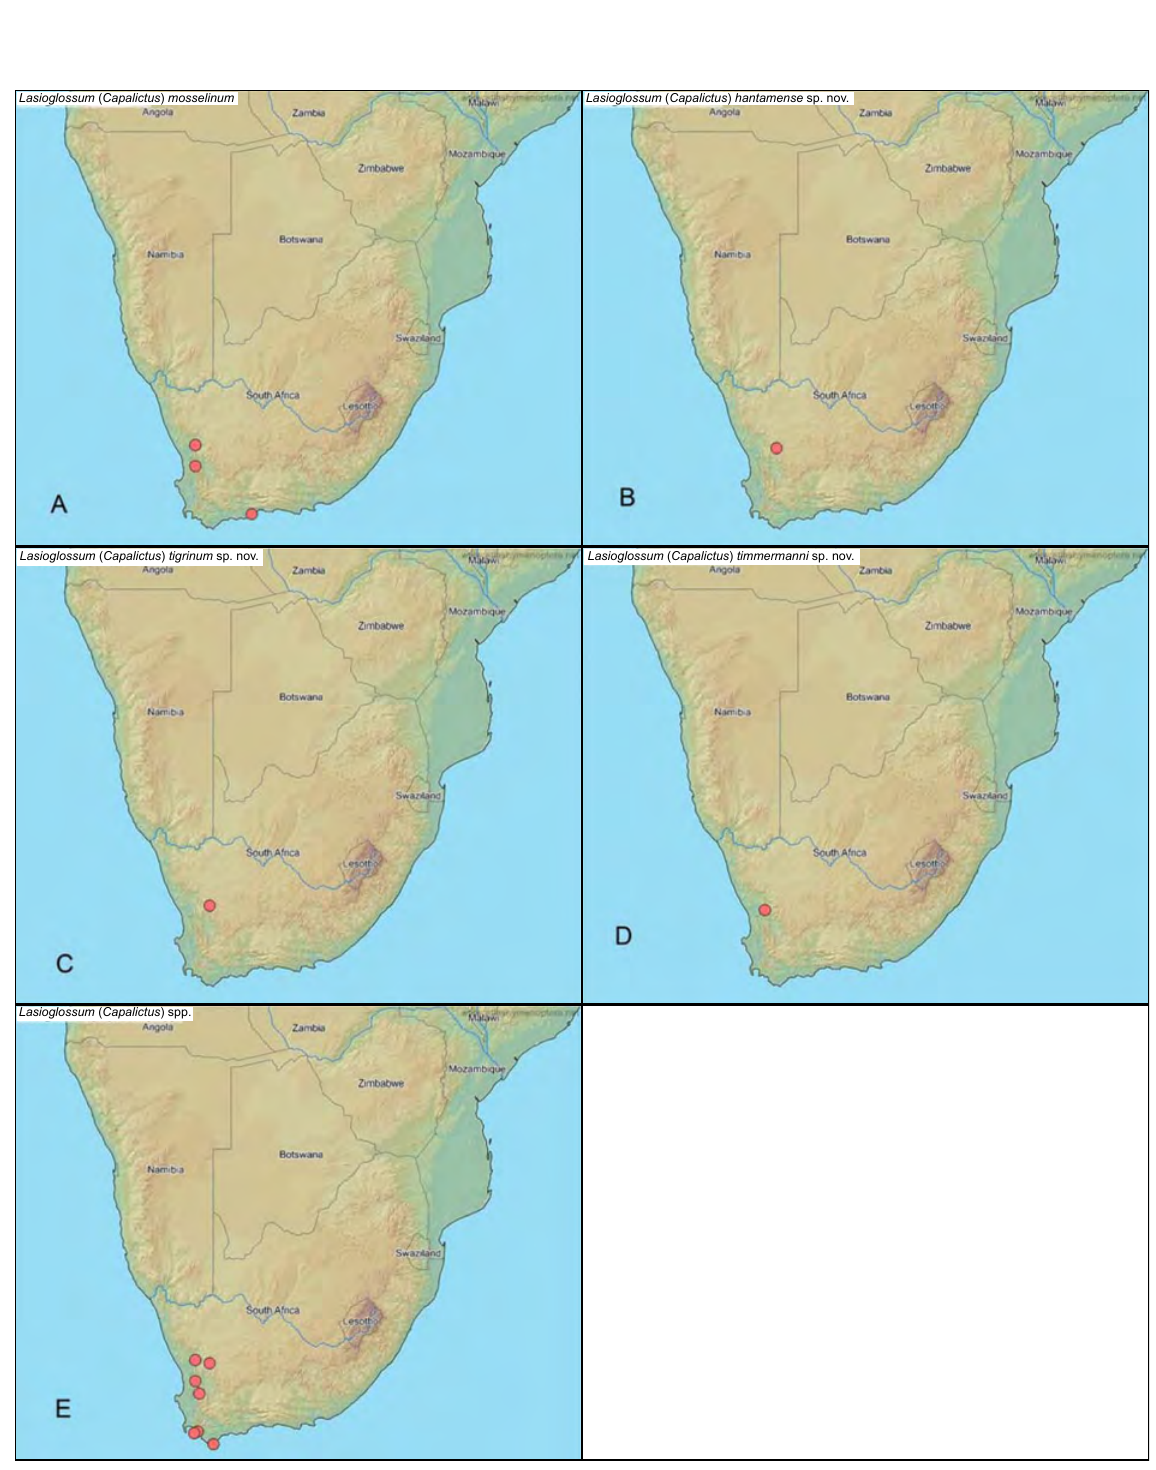
Fig. 17. Distribution maps of Lasioglossum ( Capalictus ) spp. in southern Africa. — A . Lasioglossum ( Capalictus ) mosselinum (Cockerell, 1945). — B . Lasioglossum ( Capalictus ) hantamense sp. nov. — C . Lasioglossum ( Capalictus ) tigrinum sp. nov. — D . Lasioglossum ( Capalictus ) timmermanni sp. nov. — E . Unidentified specimens of Lasioglossum ( Capalictus ) , ♀♀